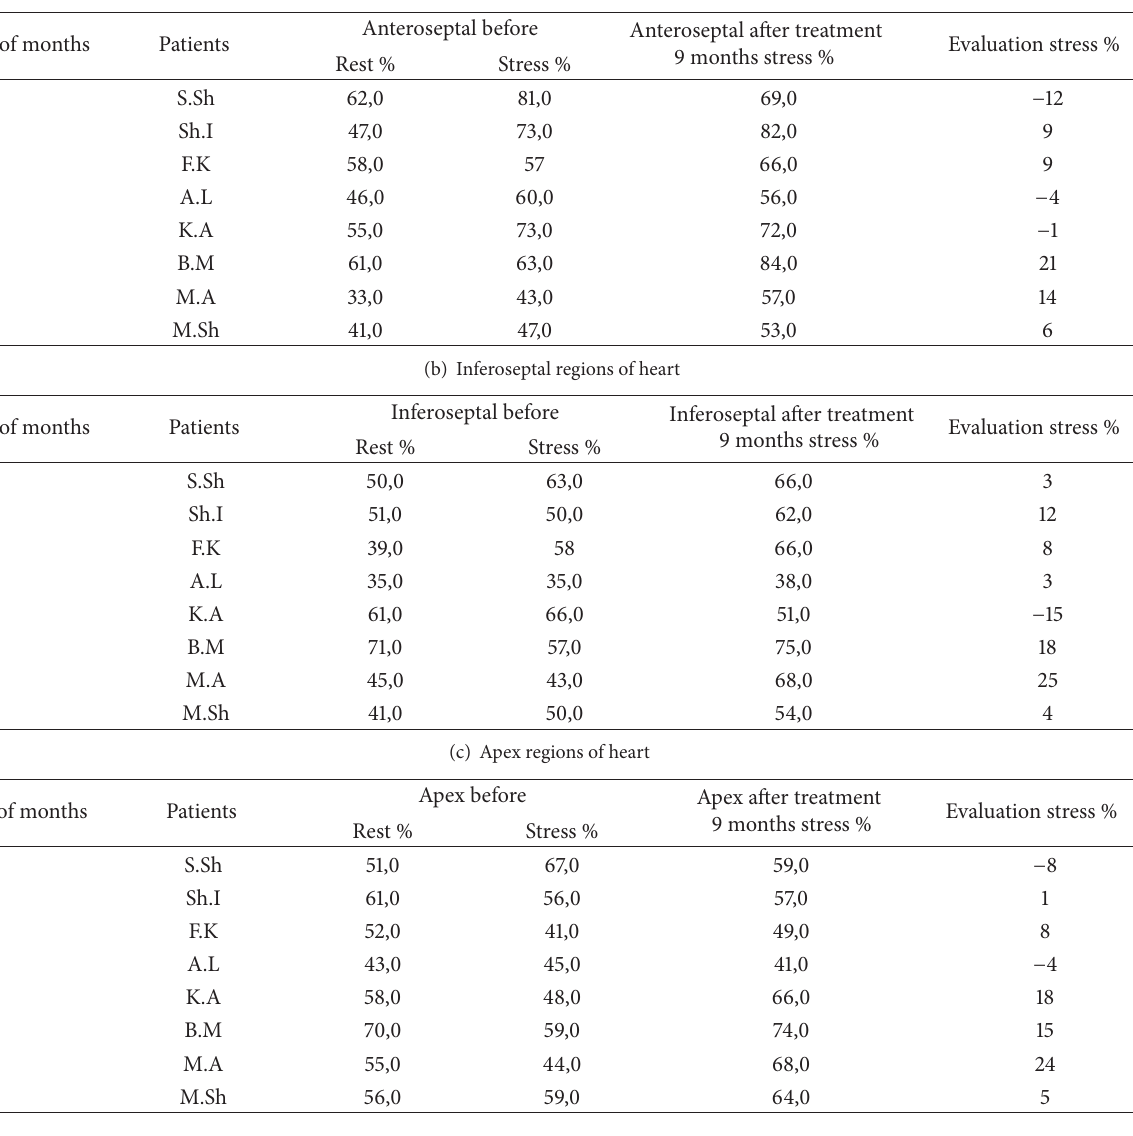
Table 3: Scintigraphy investigations of heart in 8 out of 11 patients after a period of 9 months. High inclusion of Tc99 (%) in the regions of anteroseptal (a), inferoseptal (b), and apex (c) before cell therapy (rest and stress) and after cell therapy (stress). The difference between postoperative perfusion and preoperative perfusion in stress condition presented as evaluation. (a) Anteroseptal regions of